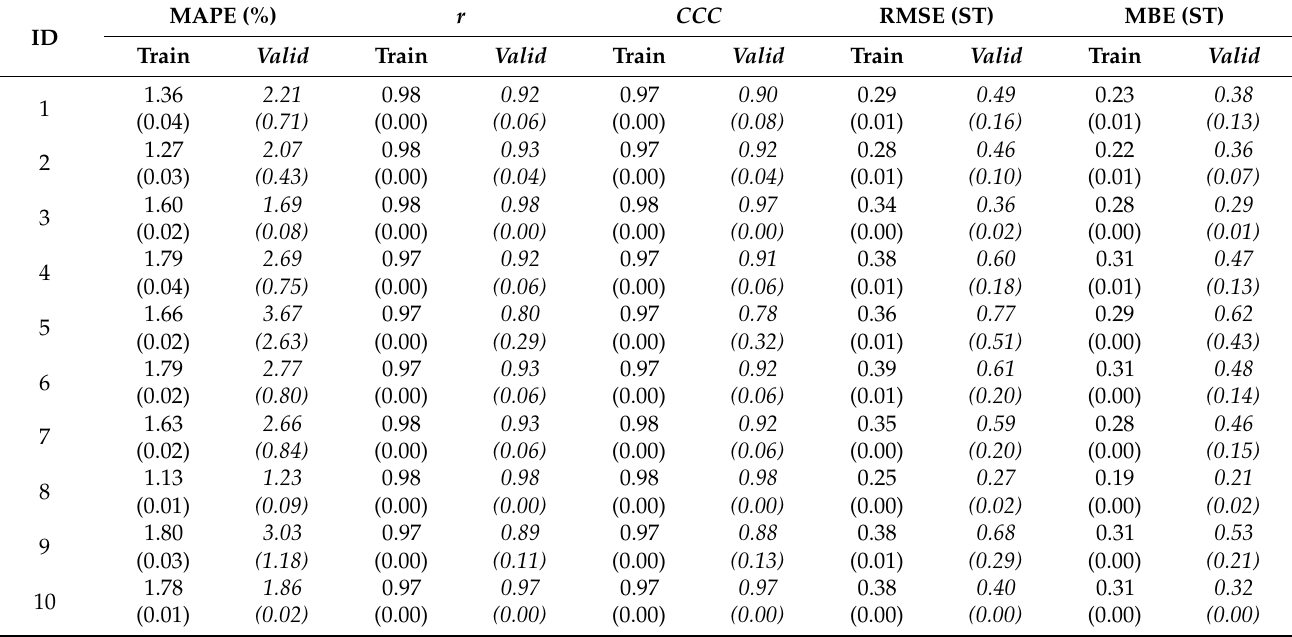
Table A2. Performance for the f o models across k = 5 cross-validation training (Train) and